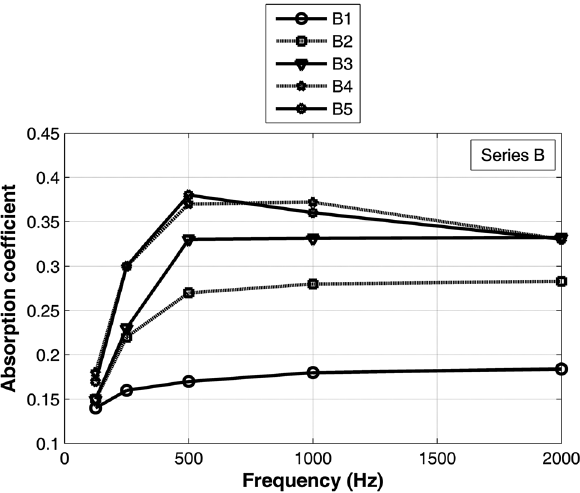
Fig. 9 Absorption coefficients of the ternary concretes of series B.